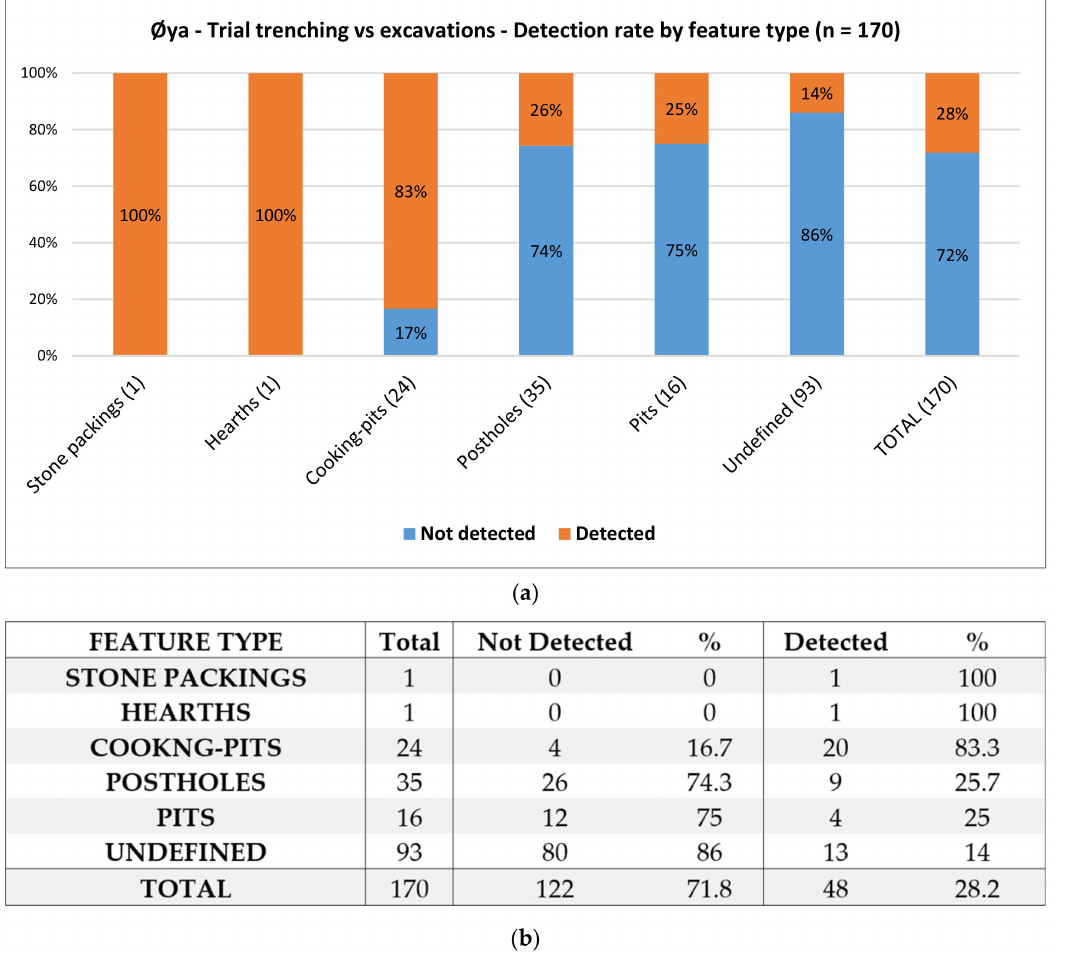
Figure 8. ( a , b ) Charts showing the relationship between detected and non-detected features within the boundaries of the trial trenches at